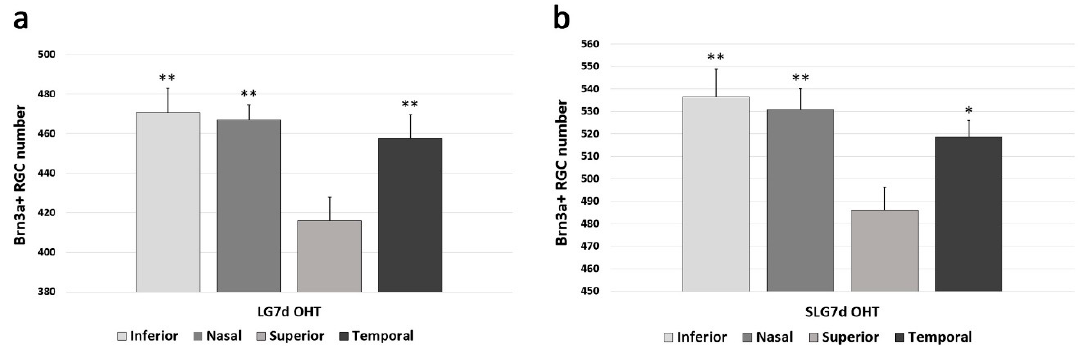
Figure 3. The number of Brn3a + RGCs in eyes untreated and treated with sa ff ron extract at day 7 after ocular hypertension (OHT) induction in the di ff erent retinal zones (inferior, nasal, superior, and temporal): ( a ) Brn3a + RGCs number in LG7d OHT; ( b ) Brn3a + RGCs number in SLG7d OHT. Histograms show the mean number ( ± standard deviation, SD) of Brn3a + RGCs per area of 0.1502 mm 2 . Abbreviations: Lasered group ocular hypertension (LG7d OHT), lasered group ocular hypertension + sa ff ron (SLG7d OHT). Statistical significance indicators: * p < 0.05, ** p < 0.01 vs. superior.